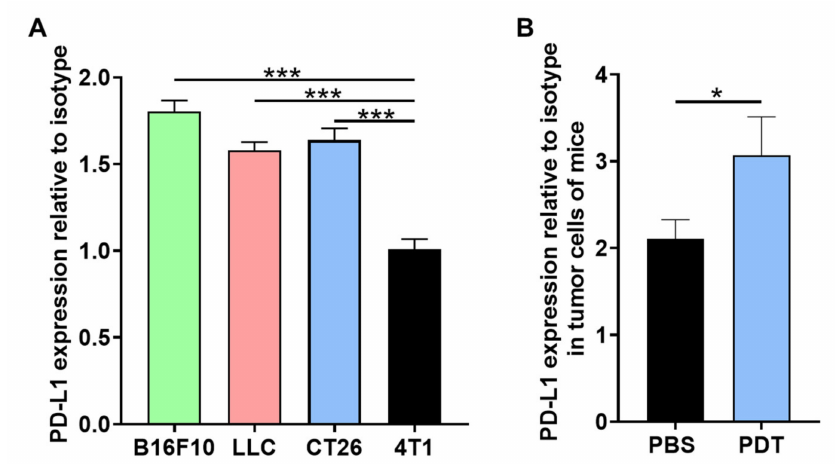
Figure 2. The PD–L1 expression in tumor cells. ( A ) The PD–L1 expression in different tumor cell lines. ( B ) The PD–L1 expression in 4T1 tumor cells in vivo after PDT for 12 h. For the PDT treatment, the mice were i.v. injected with cRGD–PaNPs–IgG (5mg/kg of Pa, 5 mg/kg of IgG). After 12 h, the tumor area received a laser irradiation (660 nm, 100 mW/cm 2 , 10 min). The mice receiving PBS without laser treatment were used as control. Data are presented with mean ± SD ( n = 3). * p < 0.05 and *** p <